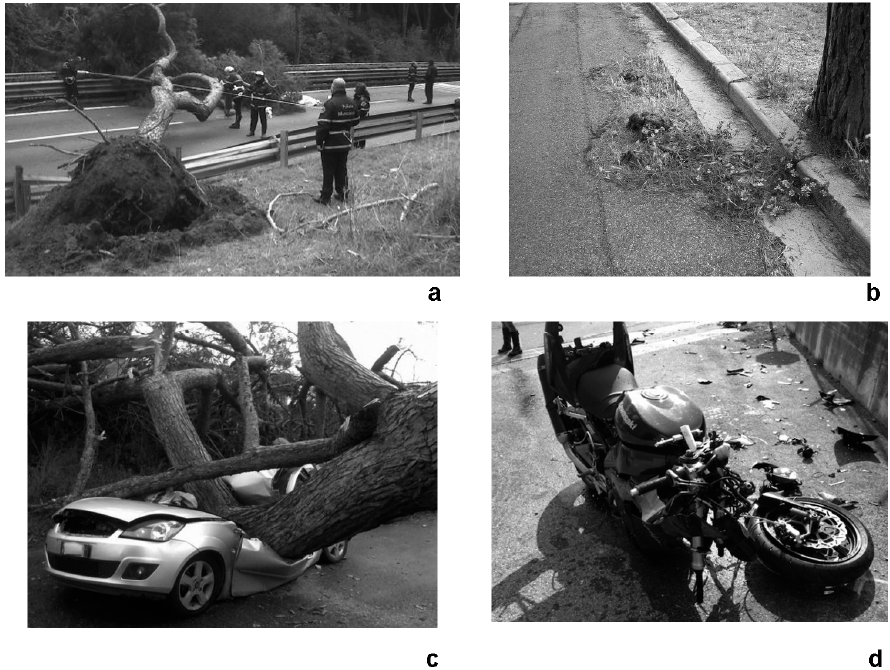
Figure 2. Recent examples of serious crashes with victims where falling trees ( a ) or root cracks ( b ) have been the responsible agent of injury, death, or vehicle damage ( c , d ) on the roads of